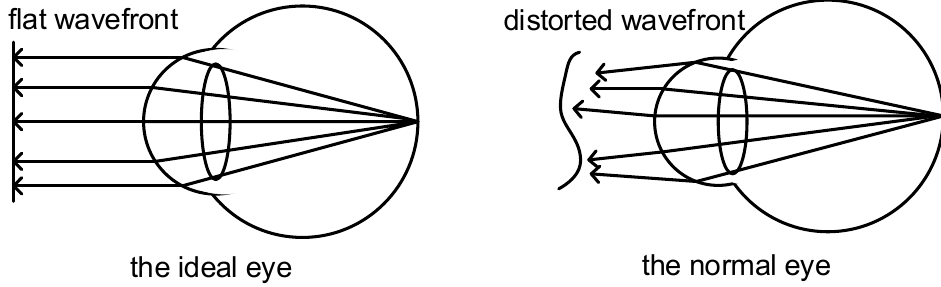
Figure 1. Schematic of wavefront shapes of ideal eye and normal eye.